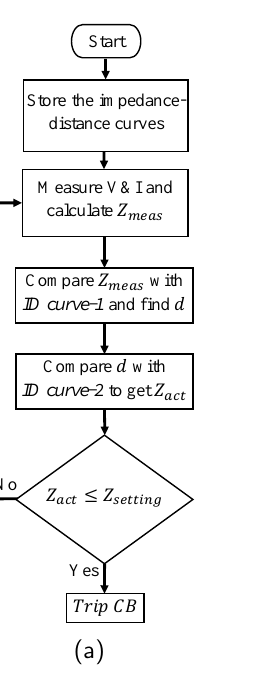
Figure 12. Method 2 for calculating the feeder impedance in presence of infeed effect: ( a ) flowchart of Method 2; ( b ) simplified schematic diagram of Method 2.